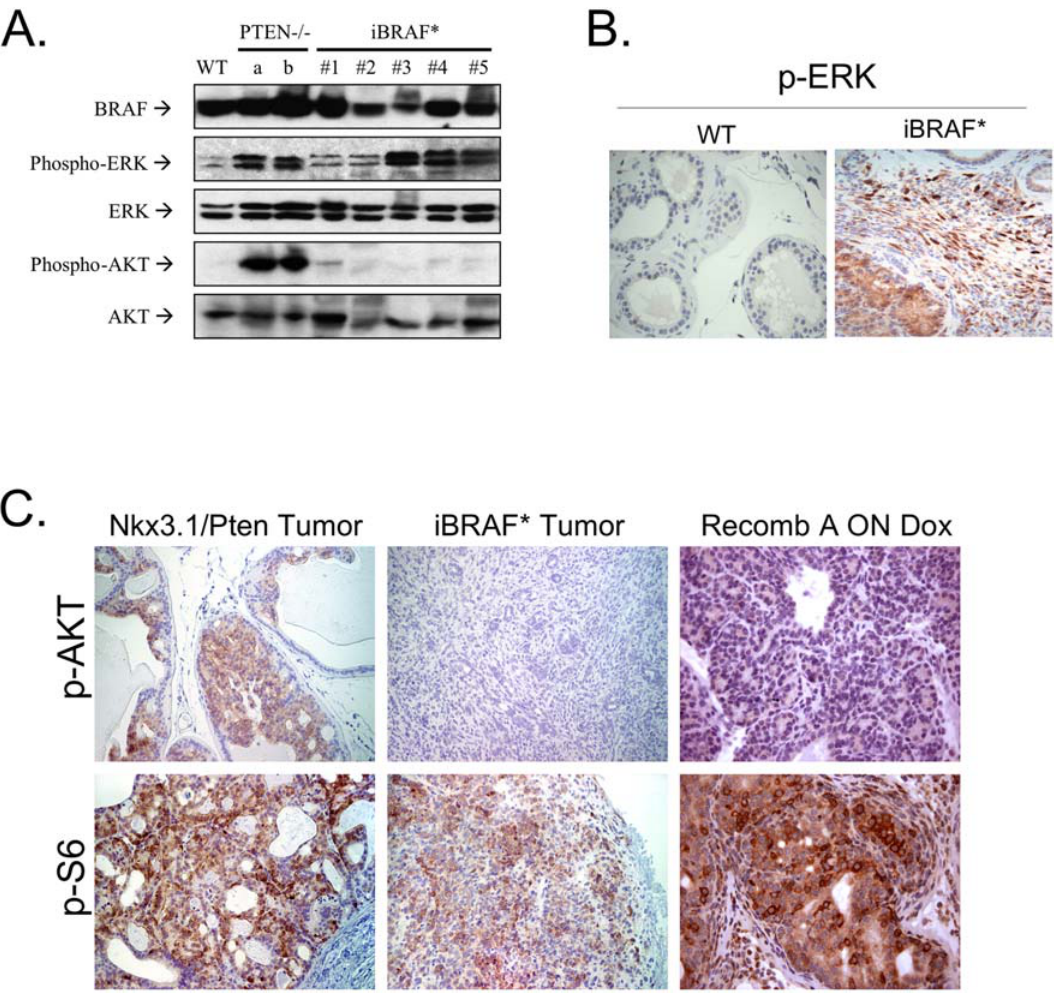
Figure 5. iBRAF* prostate tumors are AKT-independent. A, B. p-ERK activation in iBRAF* PCA tumors (n=5; on doxycycline) was detected by immunoblotting analysis ( A ) and IHC ( B ). In contrast, p-AKT activation was not detected in all iBRAF* PCA tumors (n=5; on doxycycline). Controls (a & b) were two prostate cancer samples from Pten -null mice and WT was prostate glands from a WT mouse. C. p-AKT immunoreactivity was not detected on iBRAF* PCA tumors (n=17) and Recomb A (a recombinant of iBRAF* transgenic mouse epithelium and rat mesenchyme on doxycycline) by IHC, but strong immunoreactivity of p-S6 was still present. PCA sample from Nkx 3.1 2 / 2 , Pten + / 2 compound mutant mice were used as control.